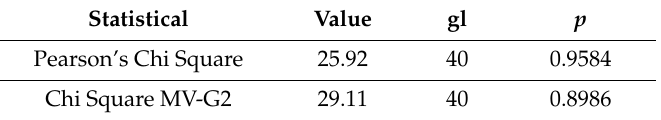
Table 7. Chi square contingency table of education and purpose of the game.